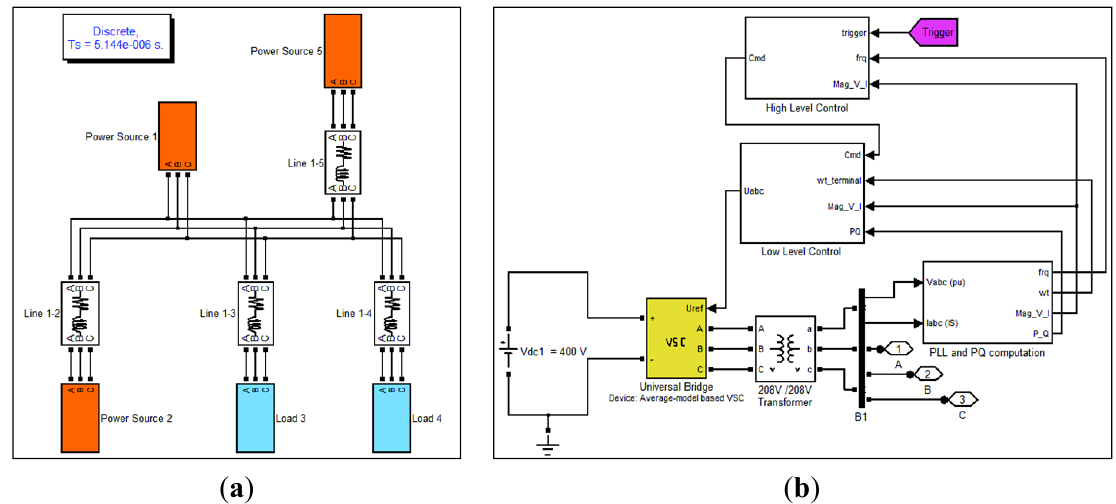
Figure 4. ( a ) Grid model programmed in Matlab/Simulink ® Simpowersystems; ( b ) Detailed view of the power source block. The power dispatch control algorithm is located in the “High Level Control”